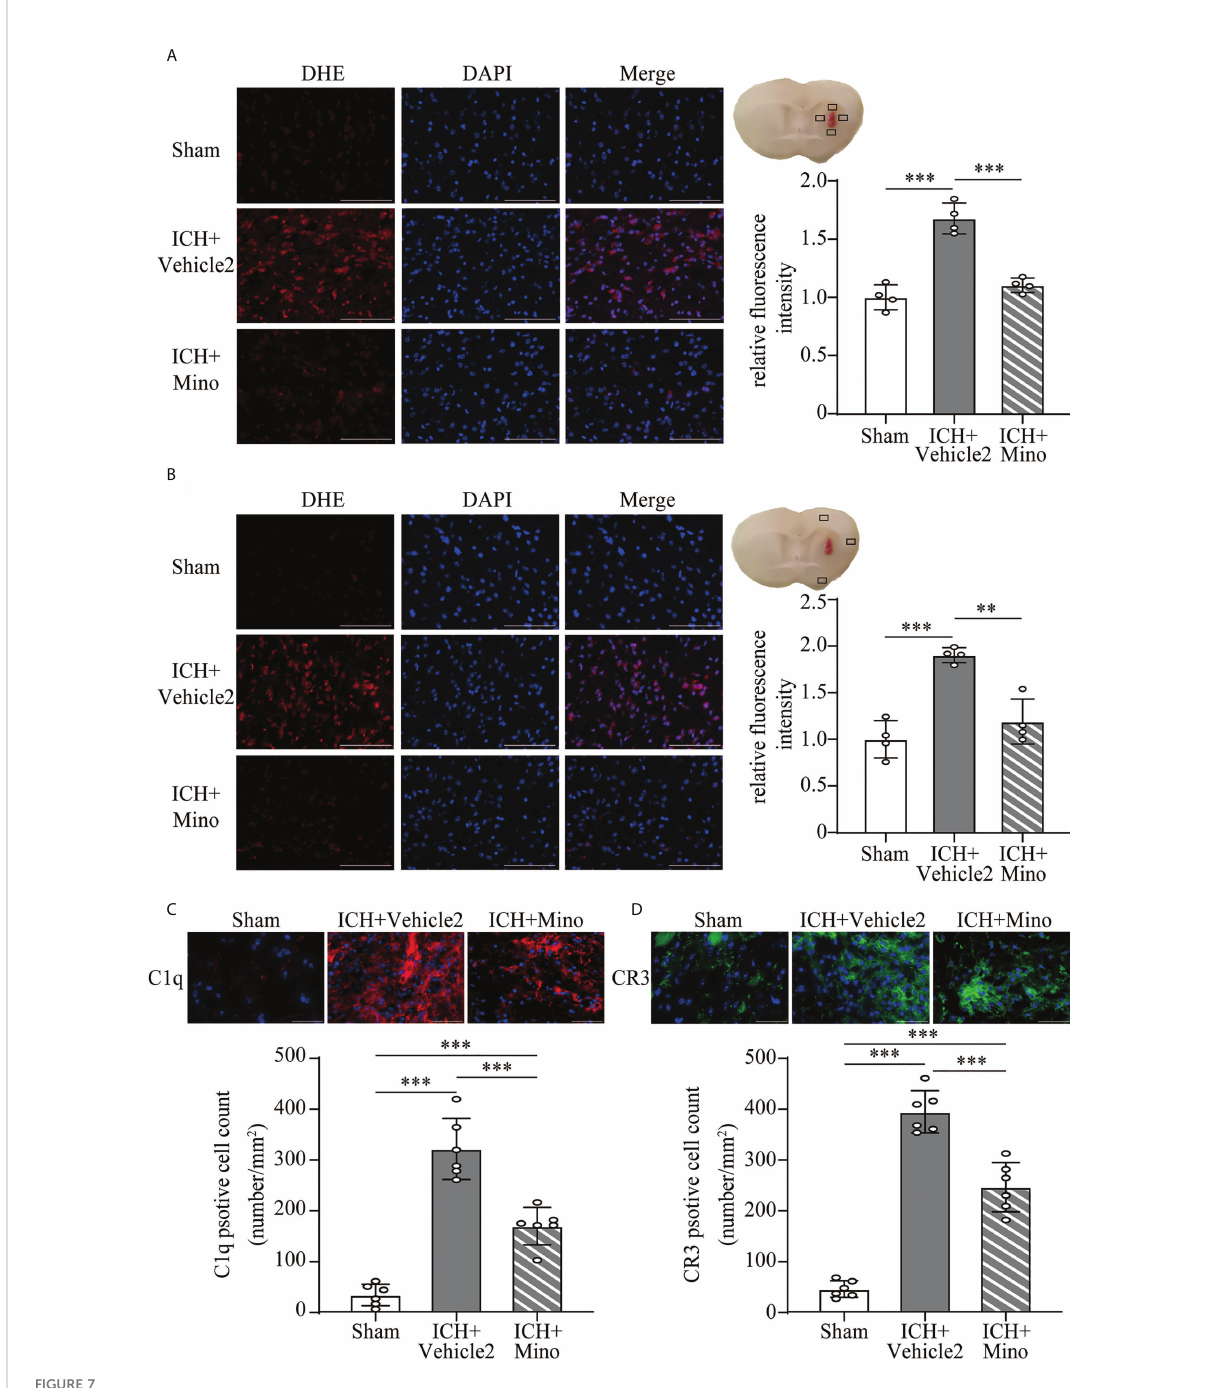
FIGURE 7 The effect of minocycline on oxidative stress and C1q, CR3 expression after ICH. (A, B) Representative microphotographs and quantitative analysis of the relative fl uorescence intensity of DHE in the perihematomal area and ipsilateral cerebral cortex after ICH. Scale bar = 100 m m. n = 4. **P <0.01, ***P <0.001 by one-way ANOVA. (C, D) Representative immuno fl uorescent image and quantitative analysis of C1q and CR3 positive cells after ICH. Scale bar = 50 m m. n = 6. ***P <0.001 by way of one-way ANOVA. Data are represented as mean ±